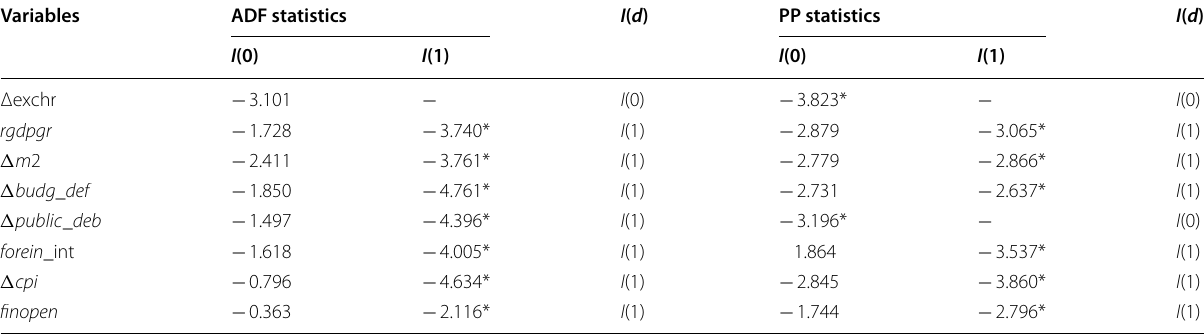
Table 1 Augmented Dickey–Fuller (ADF) and Phillip–Perron (PP) unit-root tests. Source: E-views output. Critical values at I